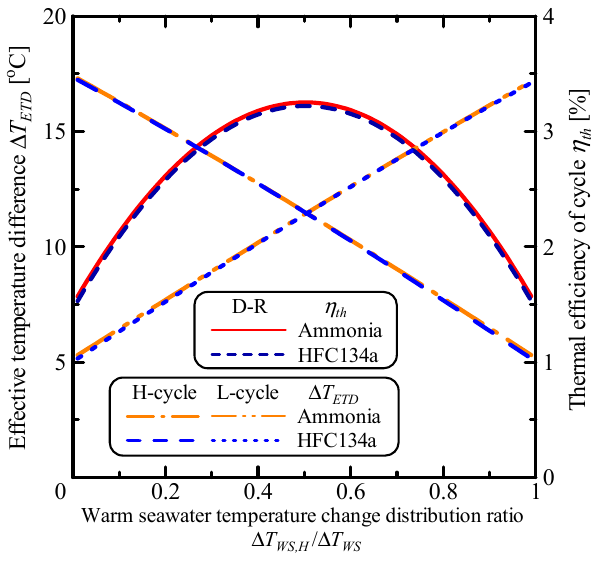
Figure 19. Relationship between the effective temperature difference and the warm seawater temperature change.